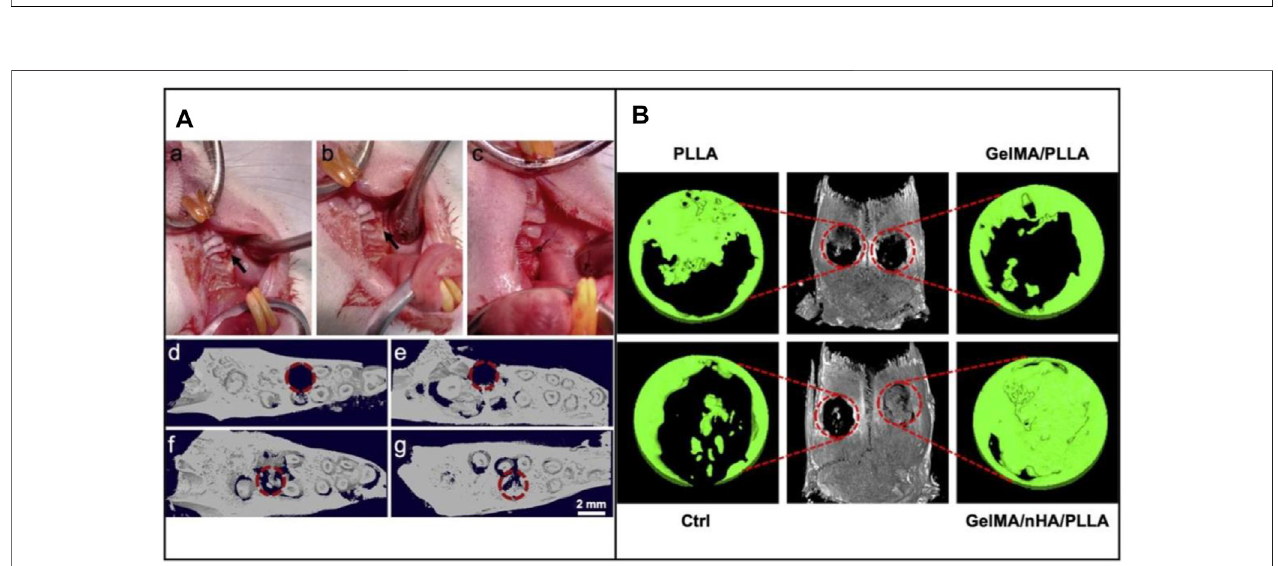
FIGURE 5 | (A) Intraoperative image of the critical-sized defect created in rat maxillae (upper jaw) after extraction of the fi rst molar tooth. (a) Defect drilled into the upper jaw bone (indicated by arrow), (b) Filling of defect with mineralized nano fi ber graft, and (c) Suturing of the tissue around the defect to hold the graft in place. Representative 3D reconstructions of coronal view micro-CT images of the defect, (d) Immediately after tooth extraction and defect creation, (e) Un fi lled defect/control after 4 weeks, (f) Defect fi lled with mineralized PLGA/collagen/gelatin nano fi ber fragments, and (g) Defects fi lled with BMP-2 loaded mineralized PLGA/collagen/ gelatin nano fi ber fragments. The dashed circles indicate the defect regions. Reproduced with permission (Boda et al., 2019). Copyright 2019, Acta Materialia Inc. (Elsevier). (B) In vivo assessment of bone regeneration capability. 3D reconstructed micro-CT images of rat cranial bone and magni fi ed images of bone defects at 12 weeks following surgery. The red circles indicate the created critical-sized 5 mm defects. Reproduced with permission (Li et al., 2020). Copyright 2020, American Chemical Society.